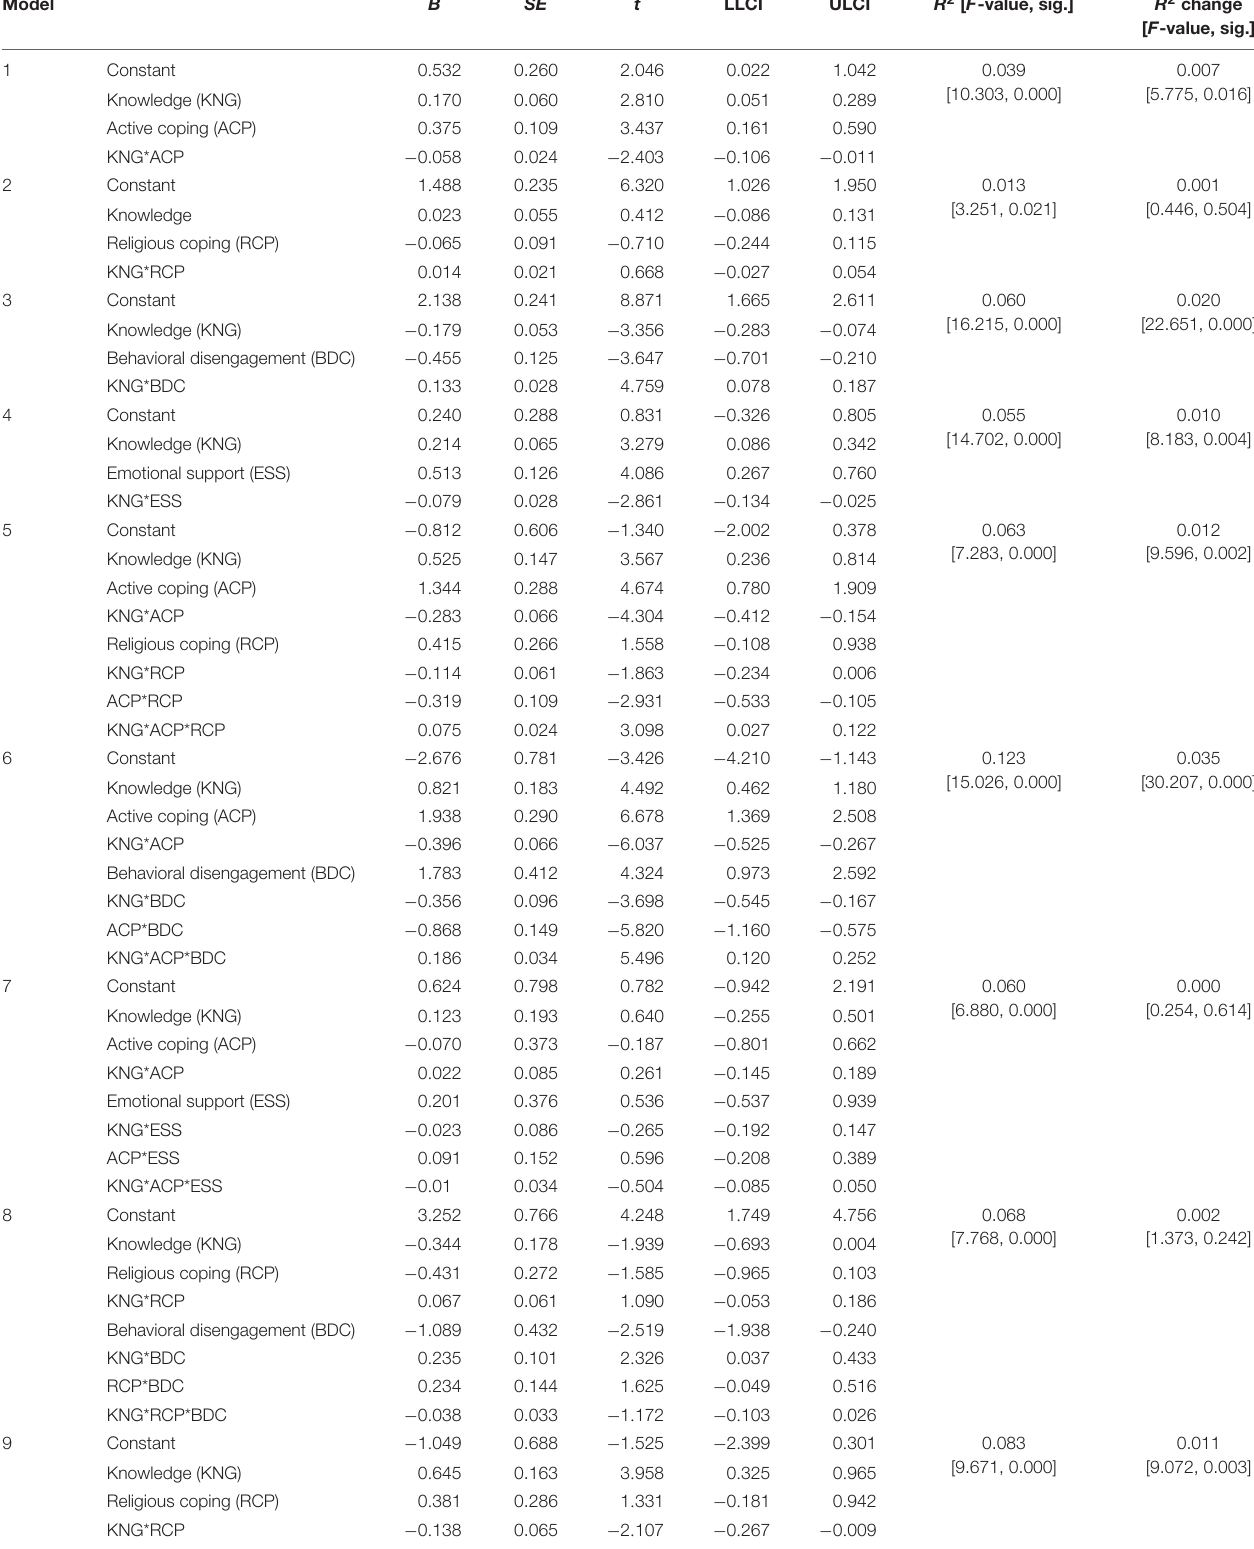
TABLE 5 | Moderated moderation of coping strategies in the relationship between COVID-19 knowledge and anxiety. Model B SE